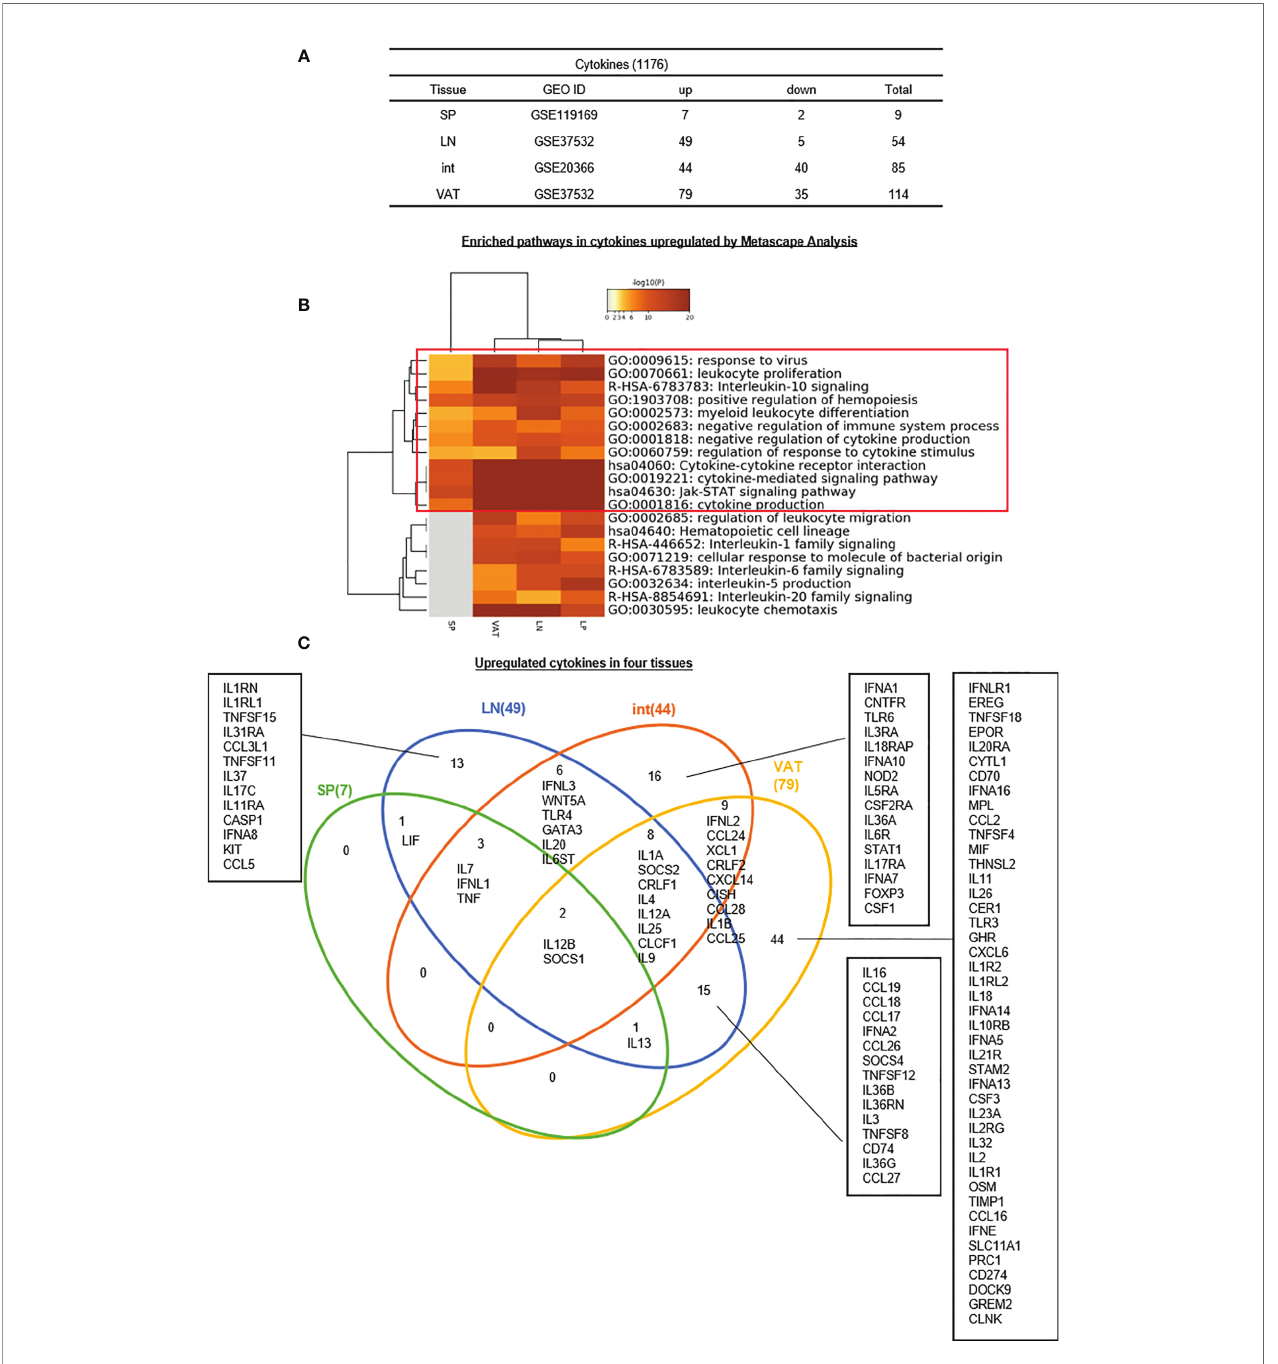
FIGURE 6 | (A – C) Thirteen LN Treg speci fi c cytokines, 16 Int Treg-speci fi c cytokines, and 44 VAT Treg-speci fi c cytokines are identi fi ed, which mediate 20 immune signaling pathways after screening for total 1,176 cytokines and their interactors (https://www.proteinatlas.org/search/cytokine) (logFC) in four tissues we studied indicated important in fl uence of Treg in cytokine production and modulation of tissue speci fi c microenvironment. Enriched pathway analysis by metascape showed that JAT-STAT signaling pathway and cytokine-cytokine receptor interaction were both modulated by up- and downregulated cytokines in Treg. One interesting fi nding was that although we have identi fi ed that IL2 may be the upstream regulator of Treg modulation; and its receptor IL2RB could induce this modulation, IL2 was downregulated in Treg from Int and VAT, which means a possibility that other interactors of IL2RB participate in this process. As IL2RB could interacts with Jak1 and RACK-1 according to NIH-NCBI Gene database (https://www-ncbi-nlm-nih-gov.libproxy.temple.edu/gene/3560). The metascape analysis also showed the important role of Jak-STAT signaling pathway, which may be a signi fi cant pathway in the modulation process of Treg, especially in non-lymphoid tissues such as int and VAT. See the detailed data in Supplementary Figure 5